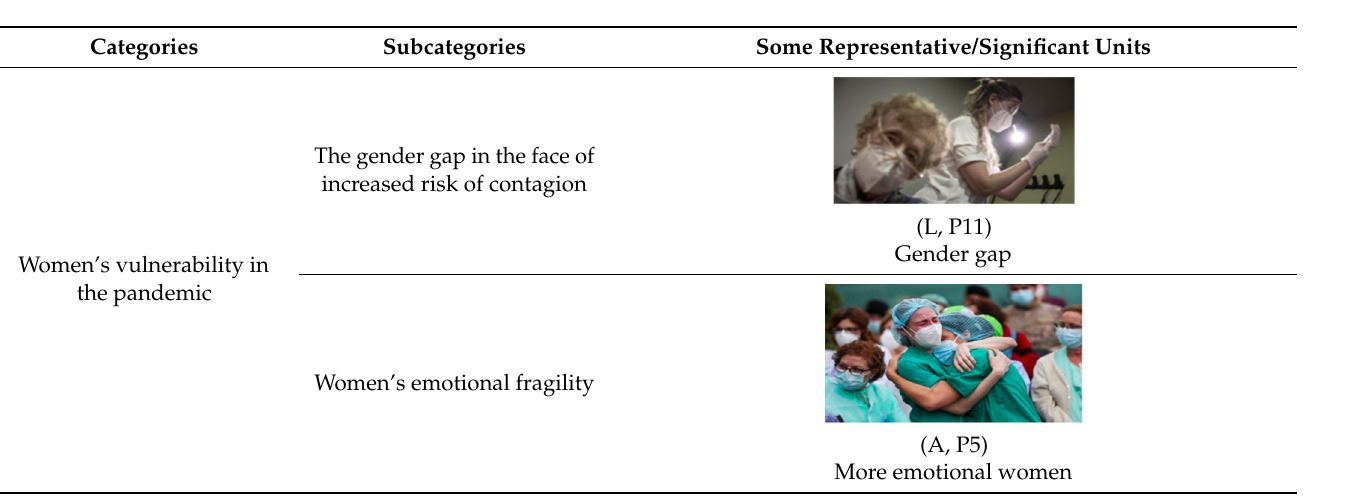
43,6 Table 2. Categories, subcategories, and representative photographs/significant units highlighted from the data. Categories Subcategories Some Representative/Significant Units Gender-related stereotypes Male leadership in a female profession (L, P55) Normalized micro sexism *Translation of tweet: “Despite the fact that in nursing there are 14% of men, the majority are nurses in management positions, who of course have a salary associated with that position” denounces the @SÁSTE trade union. By @Des_bordes “Gender gap in the health sector: discrimination against female nurses in the…” “They are more than half of the medical profession, and an overwhelming majority in nursing and the socio-health sector, but this fact has not managed to…”